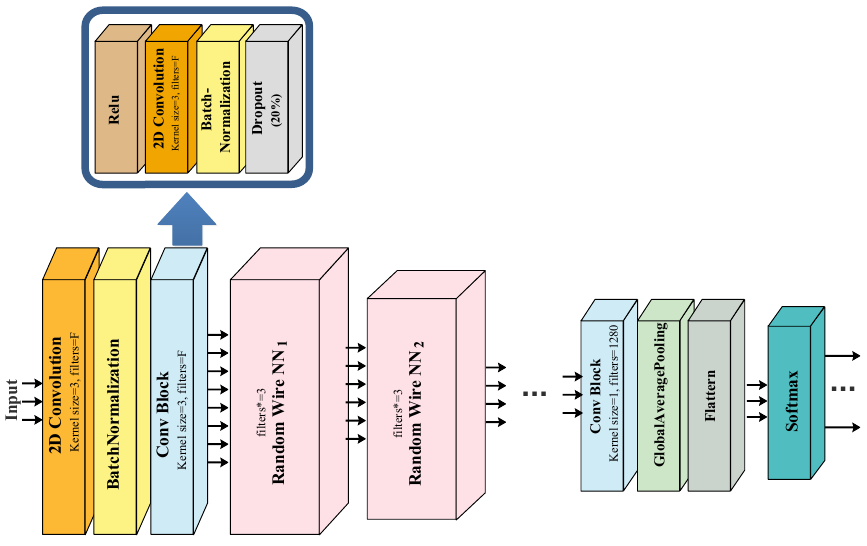
Figure 3. The architecture of a randomly wired neural